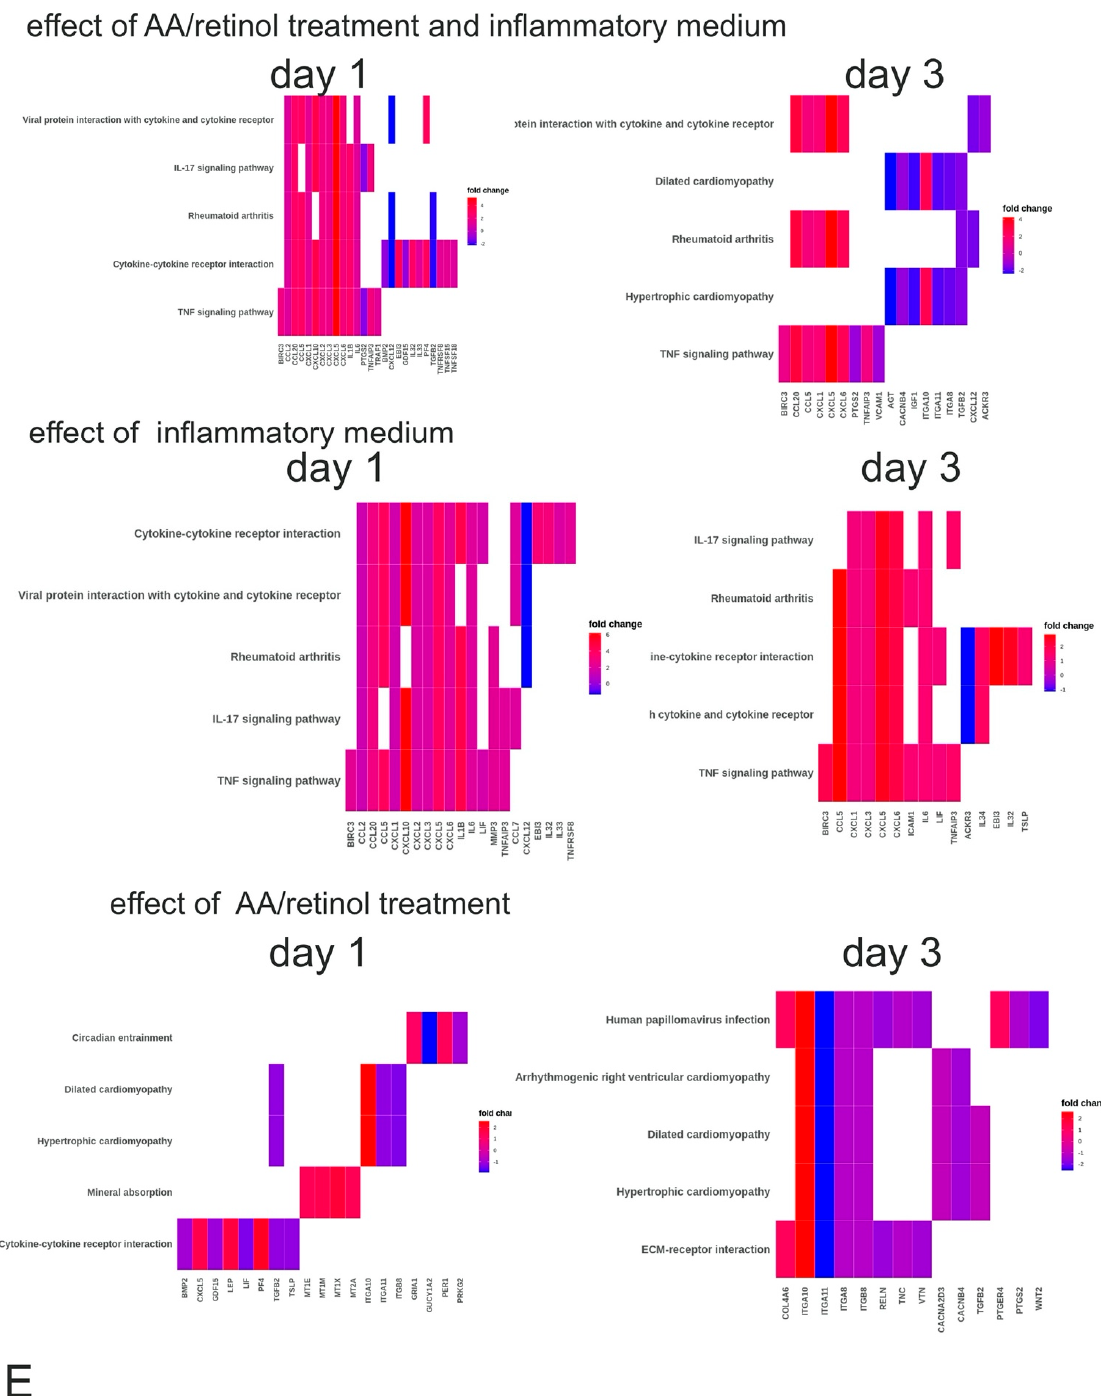
Figure 3. Visualization of gene counts and differentially expressed genes: ( A ) Heatmap of rlog-transformed gene counts for all samples on day 1 of the experiment. Labels refer to type of medium, type of treatment and proband number. ( B ) Heatmap of rlog transformed gene counts for all samples on day 3 of the experiment. Labels refer to type of medium, type of treatment and proband number. ( C ) MD plot of differentially expressed genes for the overall effect of growth medium on day 1 of the experiment, type of treatment and proband id. ( D ) MD plot of differentially expressed genes for the effect of AA/retinol treatment on day 1 of the experiment, type of growth medium and proband id. ( E ) Top five significantly represented pathways for the effects of AA/retinol treatment (lower section), medium (middle section) and the combined effect of both (upper section). Three patients were tested ( n = 3) per day (days 1 and 3). Four replicates were carried out for each